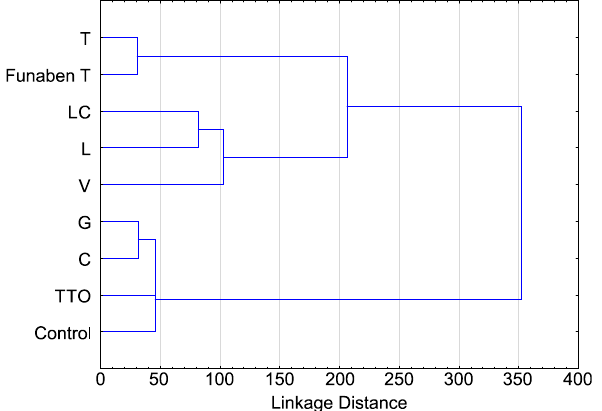
Figure 7. The clustering of the indexes of linear growth (T) of Fusarium spp. isolates (aggregate